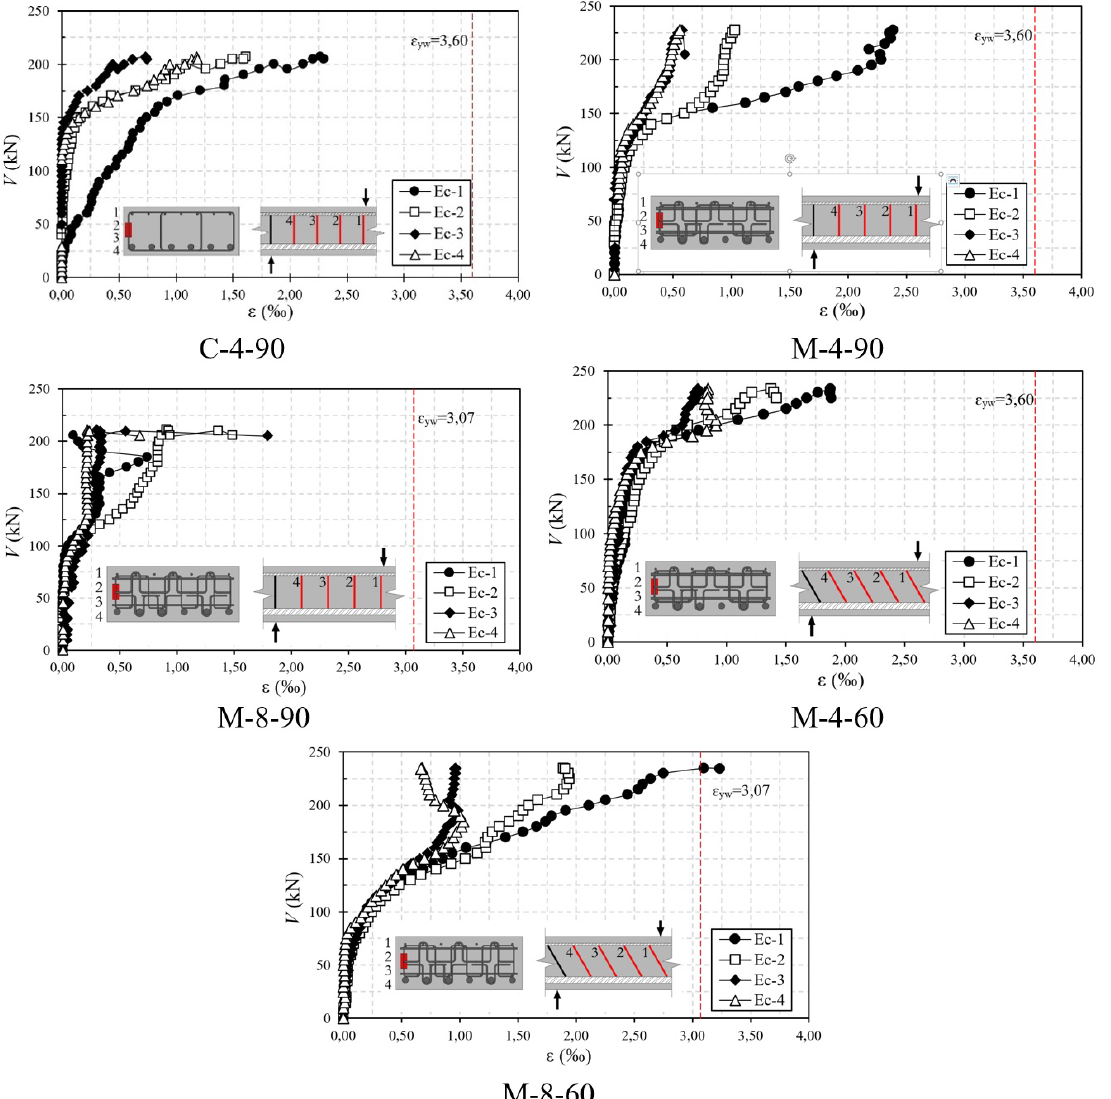
Figure 11 – Shear force versus Strain of the transverse reinforcement of the